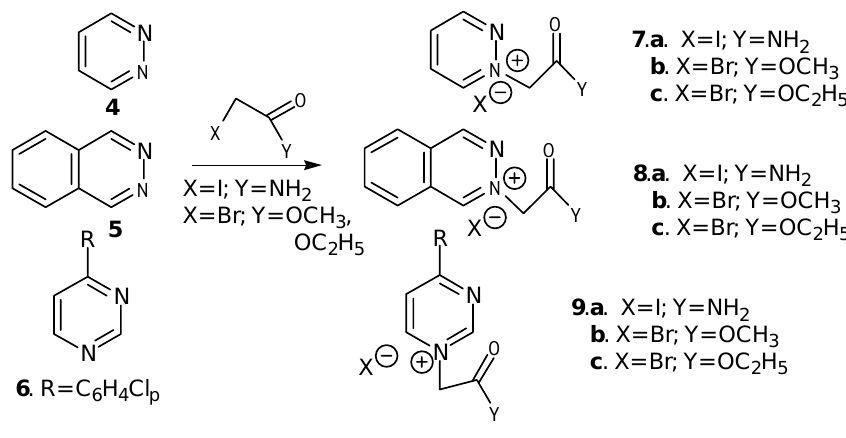
Scheme 2 . Reaction pathway for synthesis of diazinium salts.